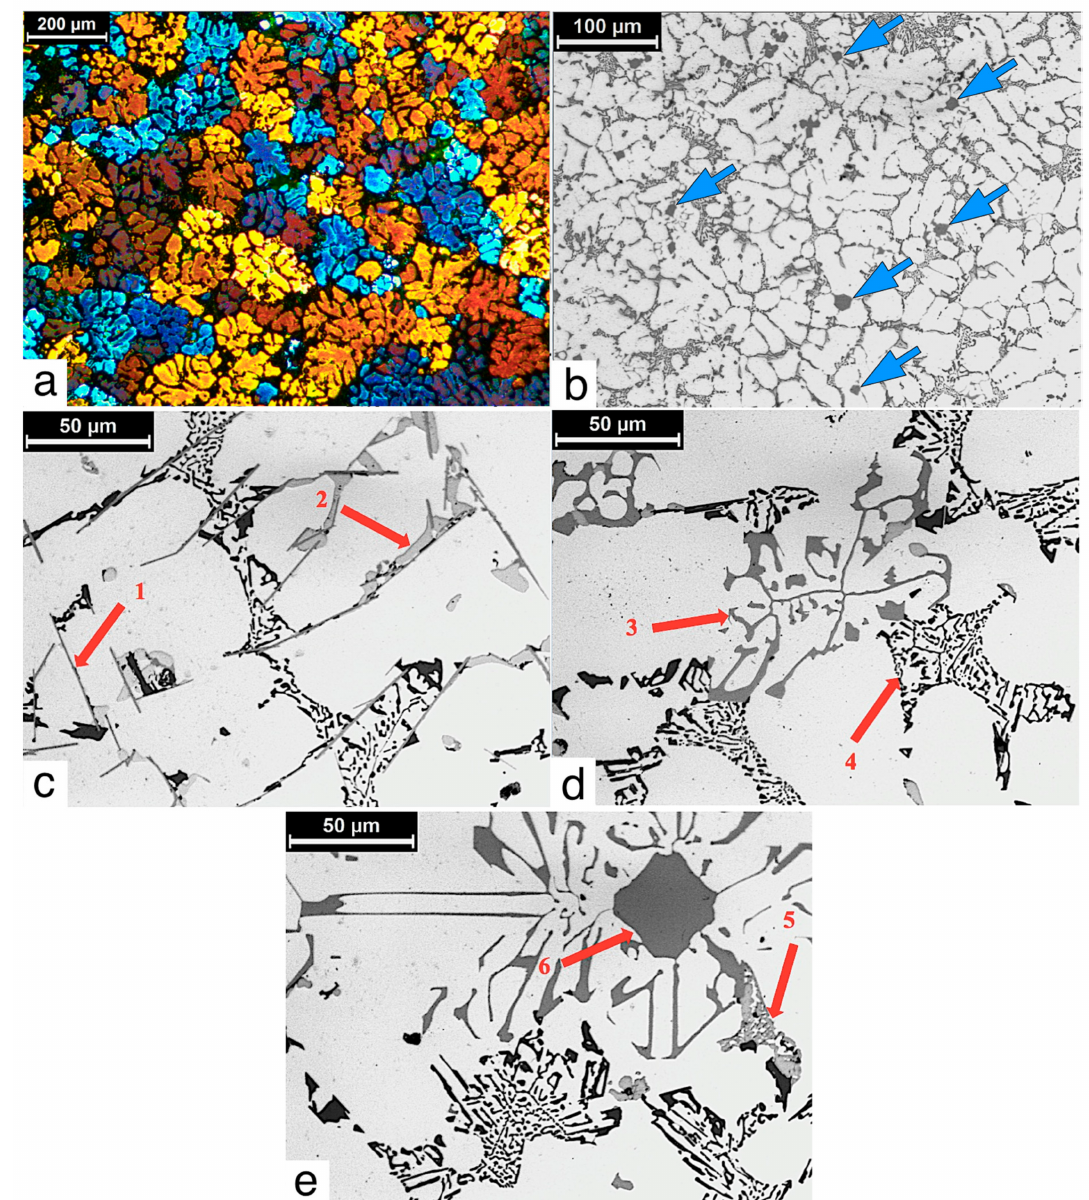
Figure 2. Micrographs of the as-cast B319+Fe alloy. ( a ) Polarized light optical micrograph highlighting grains; conventional B&W optical micrographs highlighting ( b ) globules and α -Fe polyhedral particles (blue arrows), ( c ) acicular β -Al 5 FeSi phase (arrow 1) and plates of the θ -Al 2 Cu phase (arrow 2) nucleated around β phase, ( d ) Chinese script α -Fe (Al 15 (MnFeCr) 3 Si 2 ) phase (arrow 3) and Al-Si eutectic (arrow 4), ( e ) clusters of the Al-Al 2 Cu-Si phase (arrow 5) and polyhedrons of the α -Fe (Al 15 (MnFeCr) 3 Si 2 /Al 15 (MnFe) 3 Si 2 ) phase (arrow